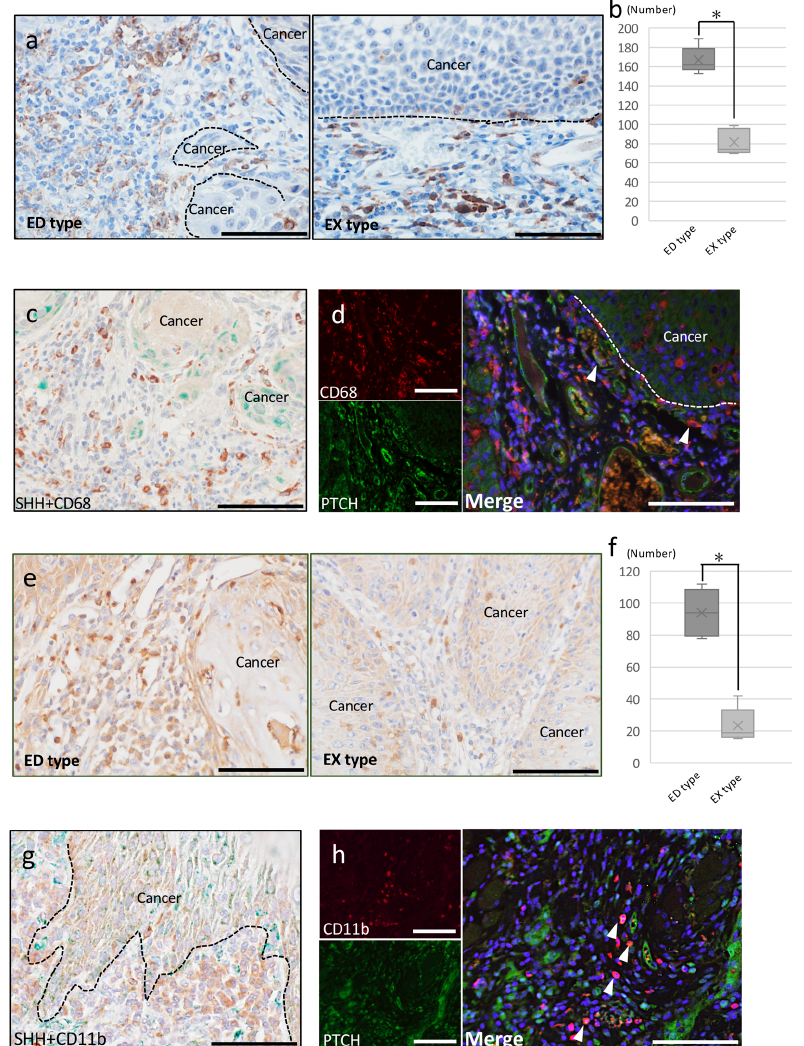
Figure 4. IHC, double IHC, and immunofluorescence of CD68 and CD11b. ( a ) IHC staining for CD68 in ED type and EX type. The accumulation of CD68-positive round- or dendritic-shape cells was observed in the cancer stroma. Scale bar: 100 μ m. ( b ) Quantification of the number of CD68-positive cells in ED type and EX type. The number of CD68-positive cells in the cancer stroma was significantly higher in ED type than in EX type. * p < 0.05 as indicated. ( c ) Double IHC staining for SHH (green)-CD68 (brown) in ED type. The expression of SHH and CD68 did not merge. However, there was a large concentration of CD68 at the site close to the cancer parenchyma where SHH expression was strong. Scale bar: 100 µ m. ( d ) Double-fluorescent IHC in ED type. Double-fluorescent IHC staining of CD68 and PTCH demonstrated that the abundant CD68-positive cells merged (arrowheads) with PTCH in ED type. Scale bar: 100 µ m. ( e ) IHC staining for CD11b in ED type and EX type. The accumulation of CD11b-positive round- or dendritic-shape cells was observed in the cancer stroma. Scale bar: 100 µ m. ( f ) Quantification of the number of CD11b-positive cells in ED type and EX type. The number of CD11b-positive cells in the cancer stroma was significantly higher in ED type than in EX type. * p < 0.05 as indicated. ( g ) Double IHC staining for SHH (green)-CD11b (brown) in ED type The expression of SHH and CD11b did not merge. However, there was a large concentration of CD68 at the site close to the cancer parenchyma where SHH expression was strong. Scale bar: 100 µ m. ( h ) Double-fluorescent IHC in ED type. Double-fluorescent IHC staining of CD11b and PTCH demonstrated that the abundant CD11b-positive cells merged (arrowheads) with PTCH in ED type. Scale bar: 100 µ